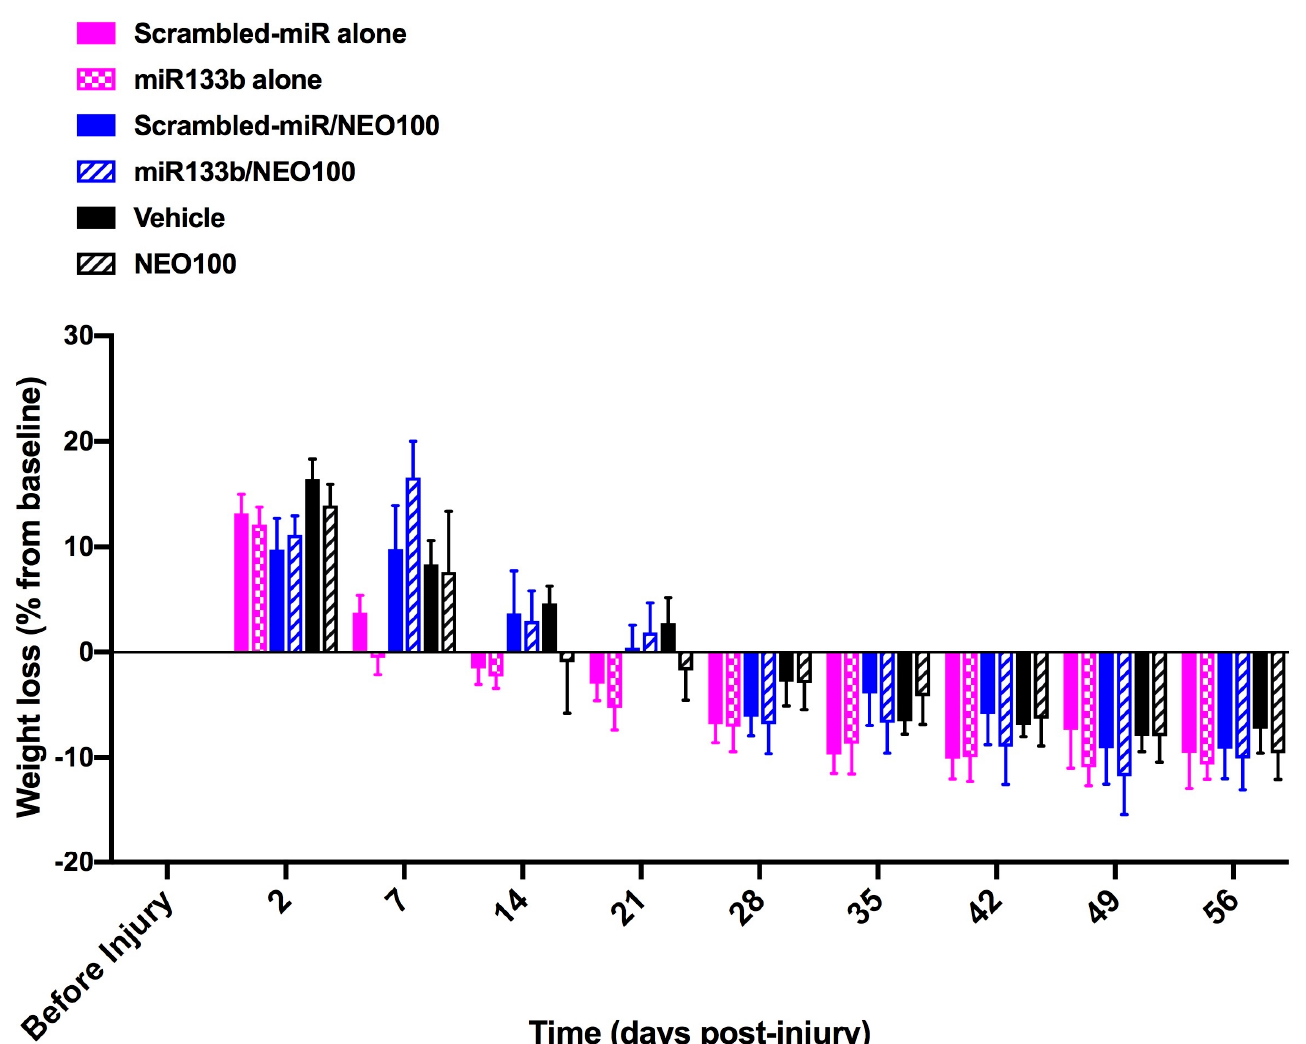
Figure 6. Weight loss assessment over the course of 56 days following the intranasal administration of either miR133/Ago2 alone or in combination with NEO100. The graph represents the weight loss over the course of 56 days following different treatments. The data are presented as percentage change from baseline (before injury). Two − way Repeated Measures ANOVA followed by the Tukey’s multiple comparison test. * p < 0.05 when compared to miR alone group.